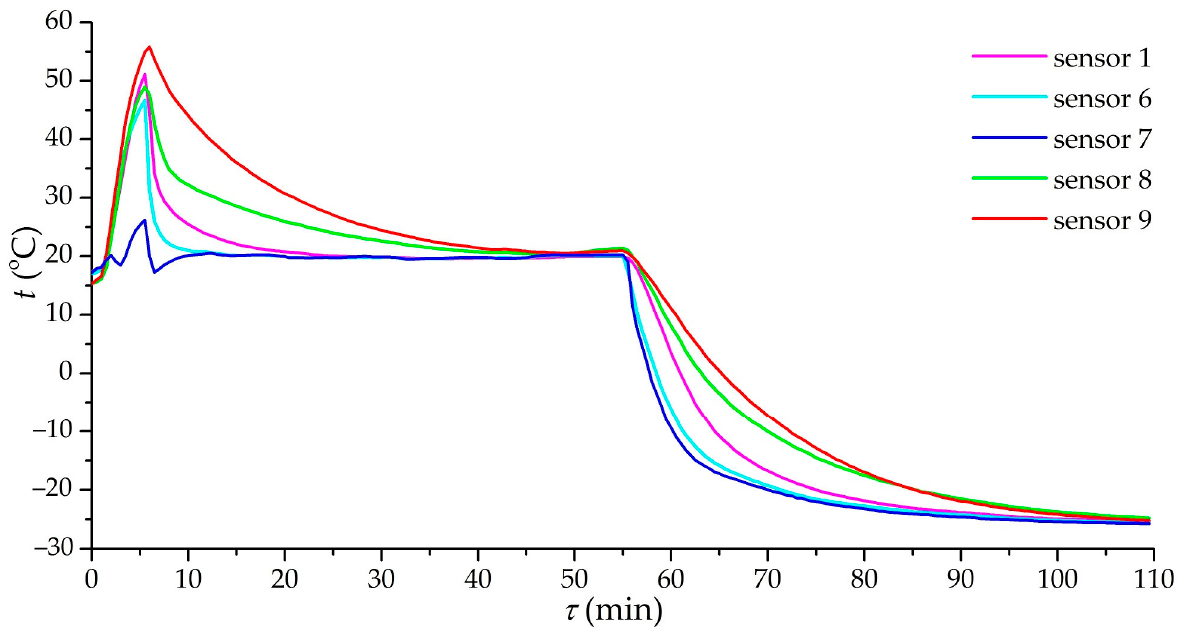
Figure 8. Dependence of the temperature of the sensors (1, 6–9) on time during charging. Charging mode: pressure of 3.5 MPa and volumetric gas flow rate of 12 m 3 /h.